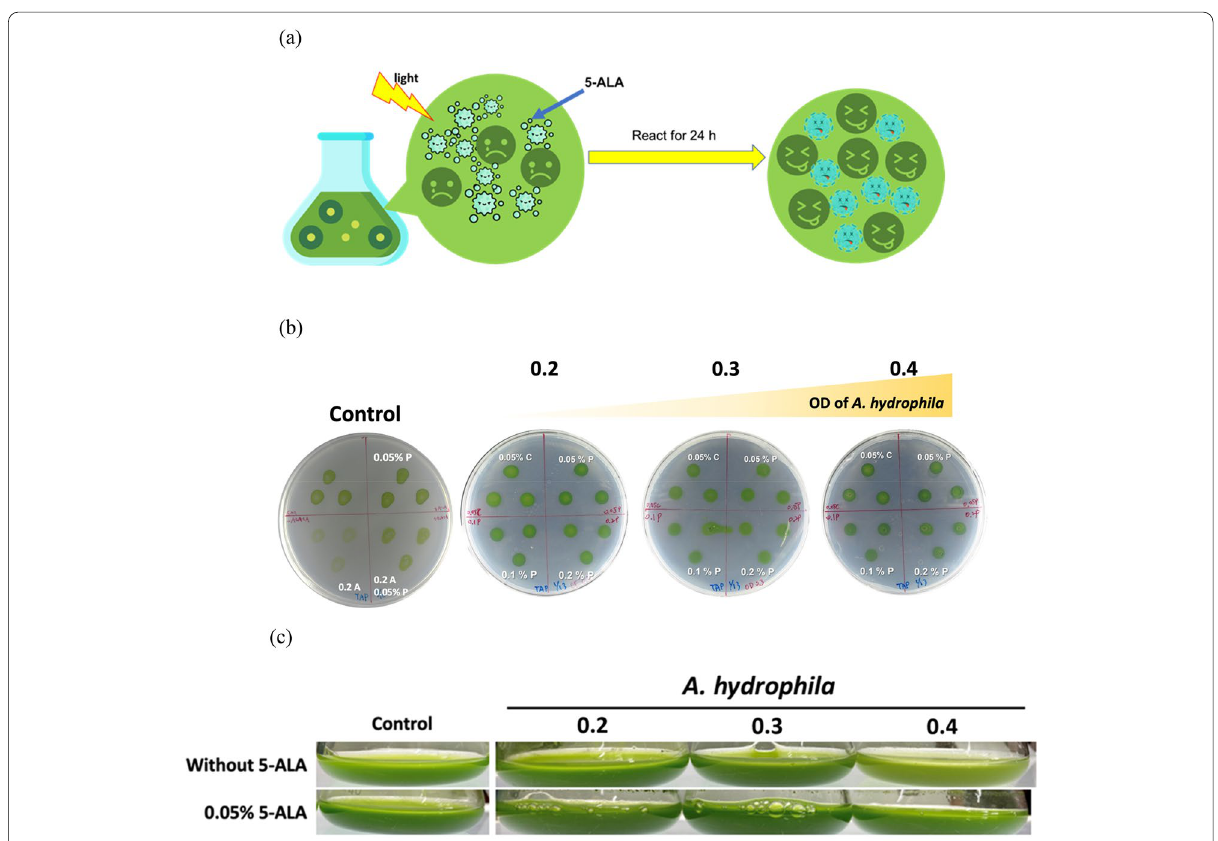
Fig. 6 (a) Schematic of experiment design for 5‑ALA against A. hydrophila, a major fish and algae pathogen. ( b) The antibacterial activity on TAP plate assay with different concentrations of 5‑ALA against different OD 600nm of A. hydrophila in microalgae C. sorokiniana culture at 30 °C for 3 days under 100 µmol/m 2 /s light intensity. C indicates the commercial 5‑ALA from Sigma (Sigma A3785) and P is the purified 5‑ALA in this study. ( c) The cultivation of C. sorokiniana with 0.05% or without 5‑ALA and different biomass of A. hydrophila in terms of OD 600 at 0.2, 0.3 and 0.4 after 3‑day